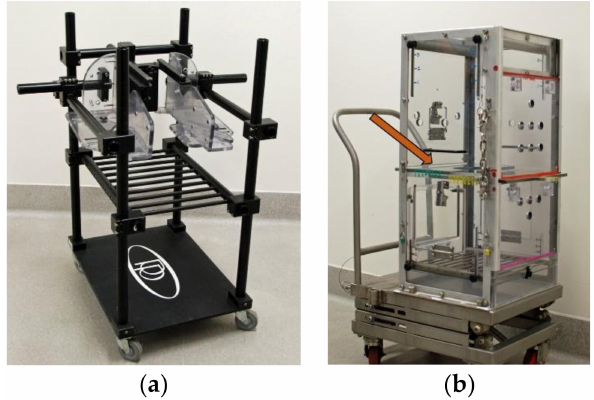
Figure 1. The open restraint chair (ORC; a ) and closed box chair (CBC; b ). Arrow indicates waist plate